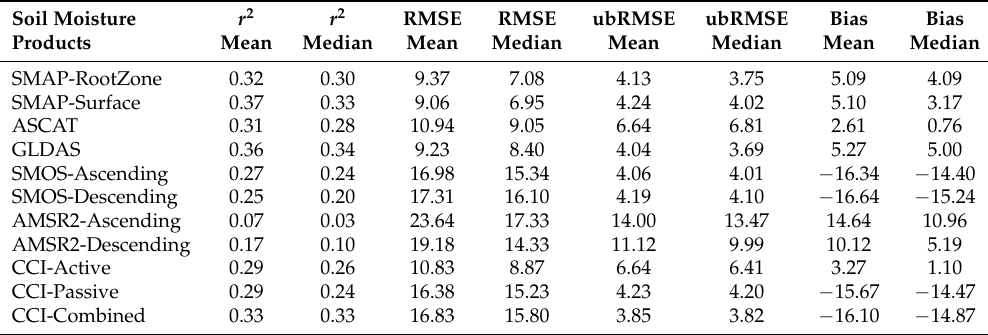
Table 2. Mean and Median Values of r 2 , RMSE, ubRMSE and bias values of soil moisture products with